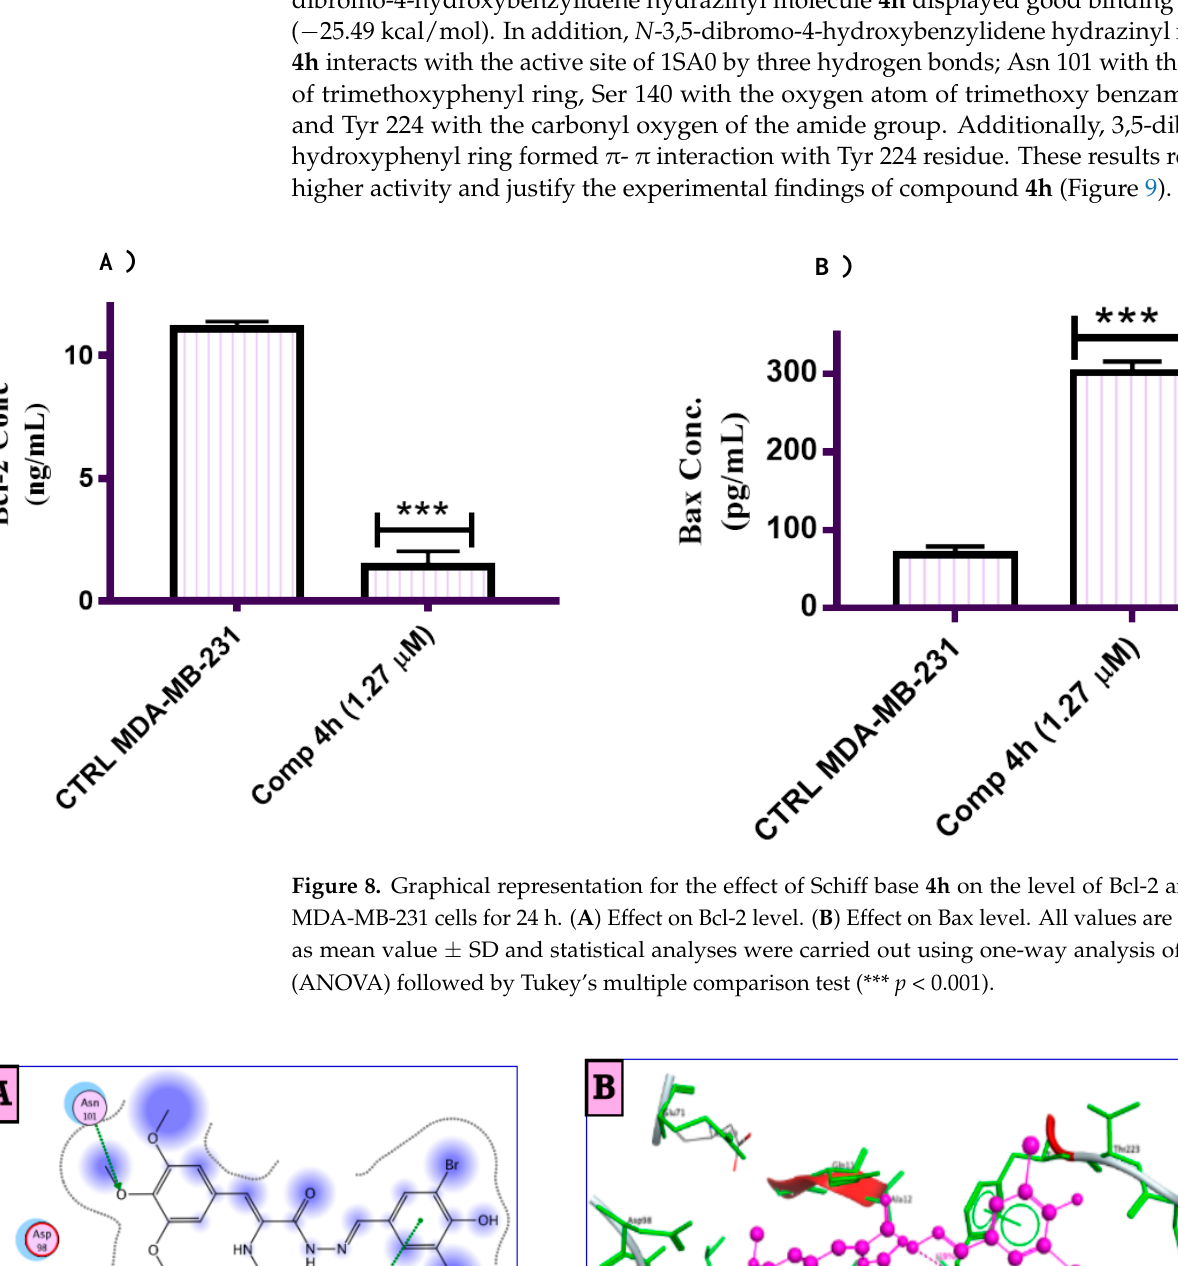
dibromo-4-hydroxybenzylidene hydrazinyl molecule 4h displayed good binding affinities